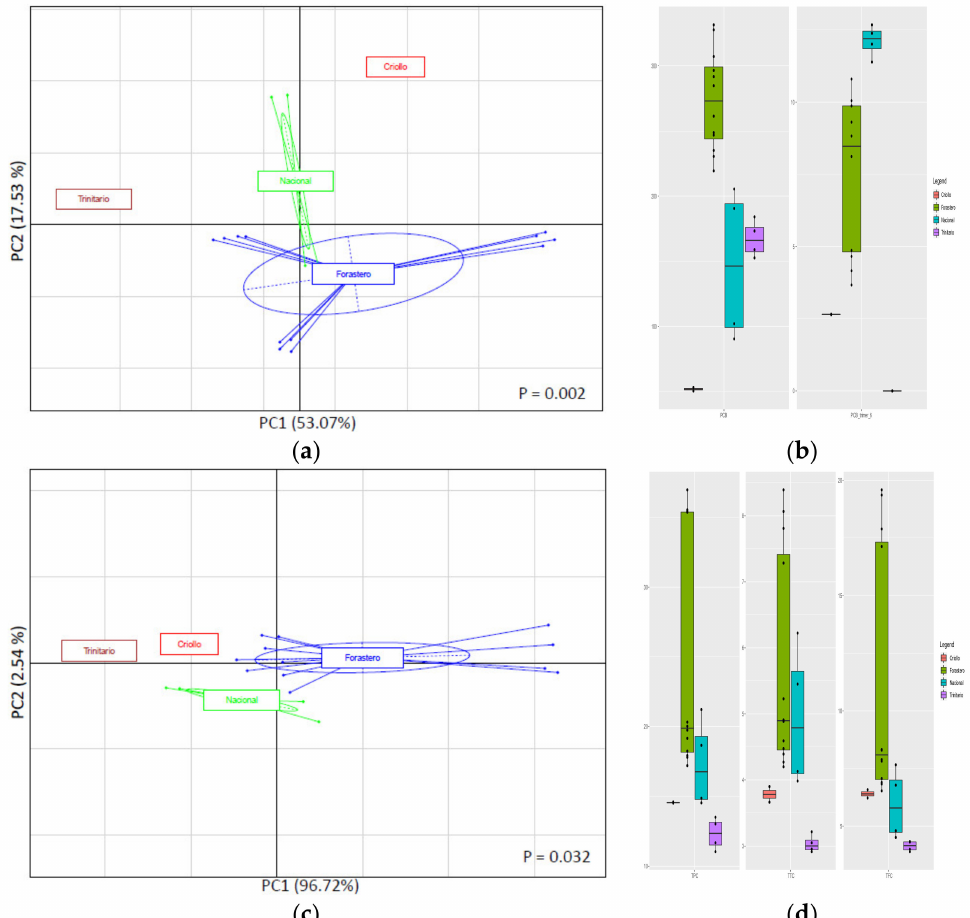
Figure 4. PCA based on HPLC-determined polyphenolic profile ( a ) and spectrophotometric analyses results ( c ) as function of CBS variety among the Ecuadorian CBS. Variance explained by first and second components of PCA is shown in parenthesis for PC1 and PC2 in each graph. Boxplots showing abundance of two key polyphenolic compounds (PCB and PCB trimer 6) ( b ) and TPC, TTC, and TFC ( d ) that can be used as possible markers for separation based on CBS variety are shown next to their correspondent PCA graph. For interpretation of legends, see Table